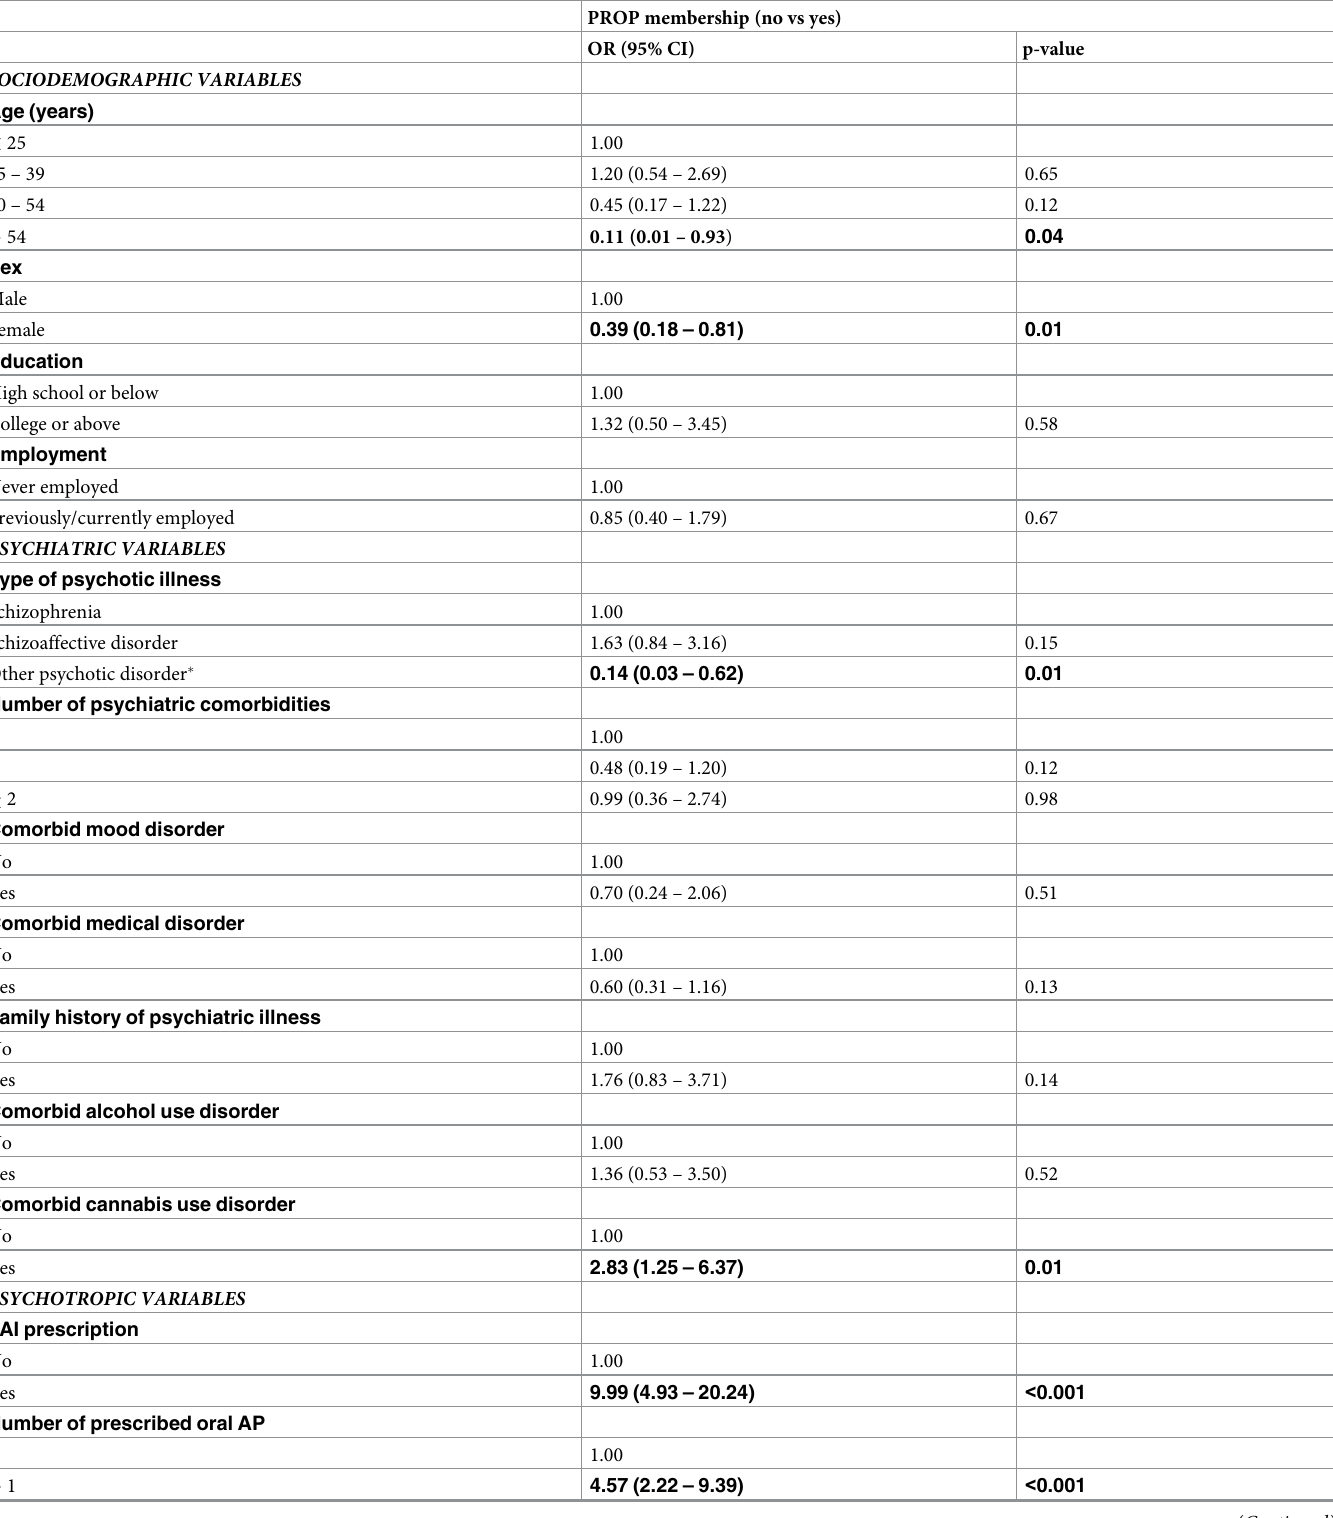
Table 2. Adjusted odds ratio with 95% confidence intervals of the association between PROP enrollment and predictors of